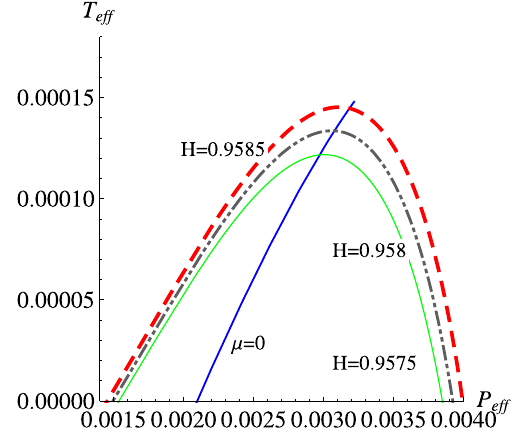
Fig. 10 The isenthalphic and inverse curves of the RN–dS spacetime